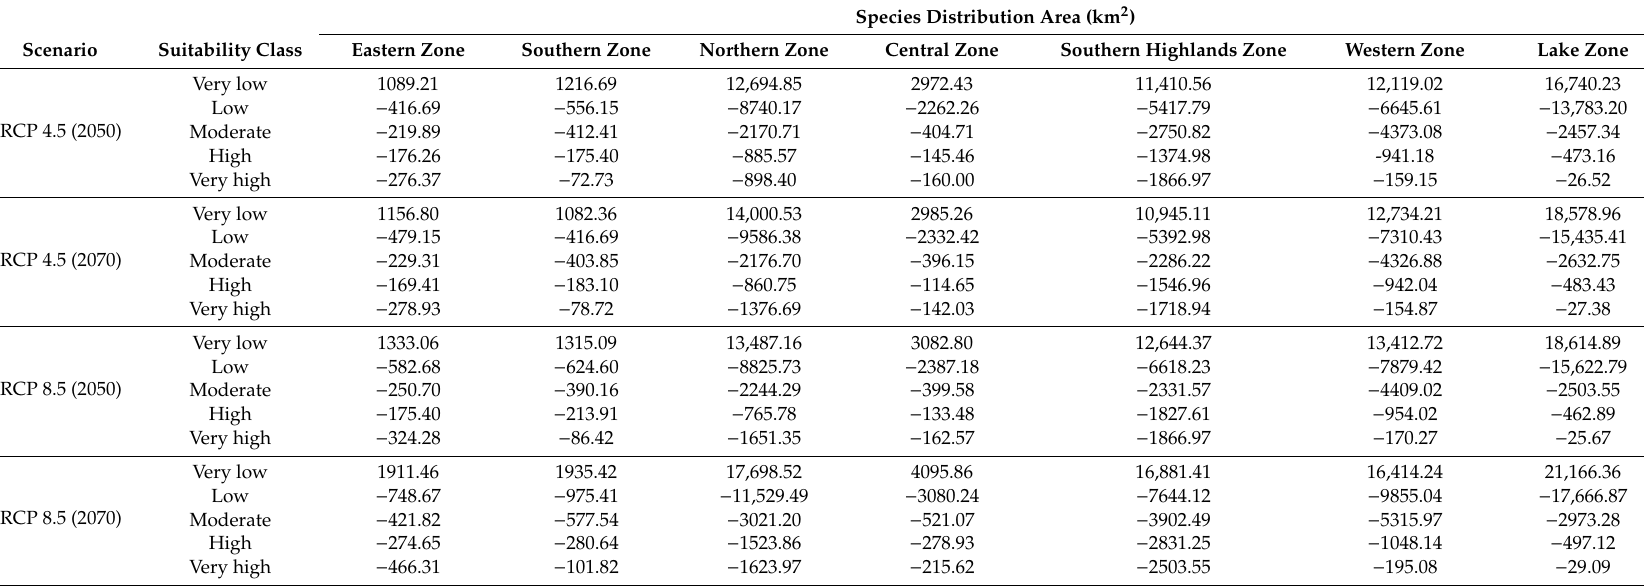
Table 5. Change in suitable areas of P. africana zone wide for mid-century and late-century under RCP 4.5 and RCP 8.5